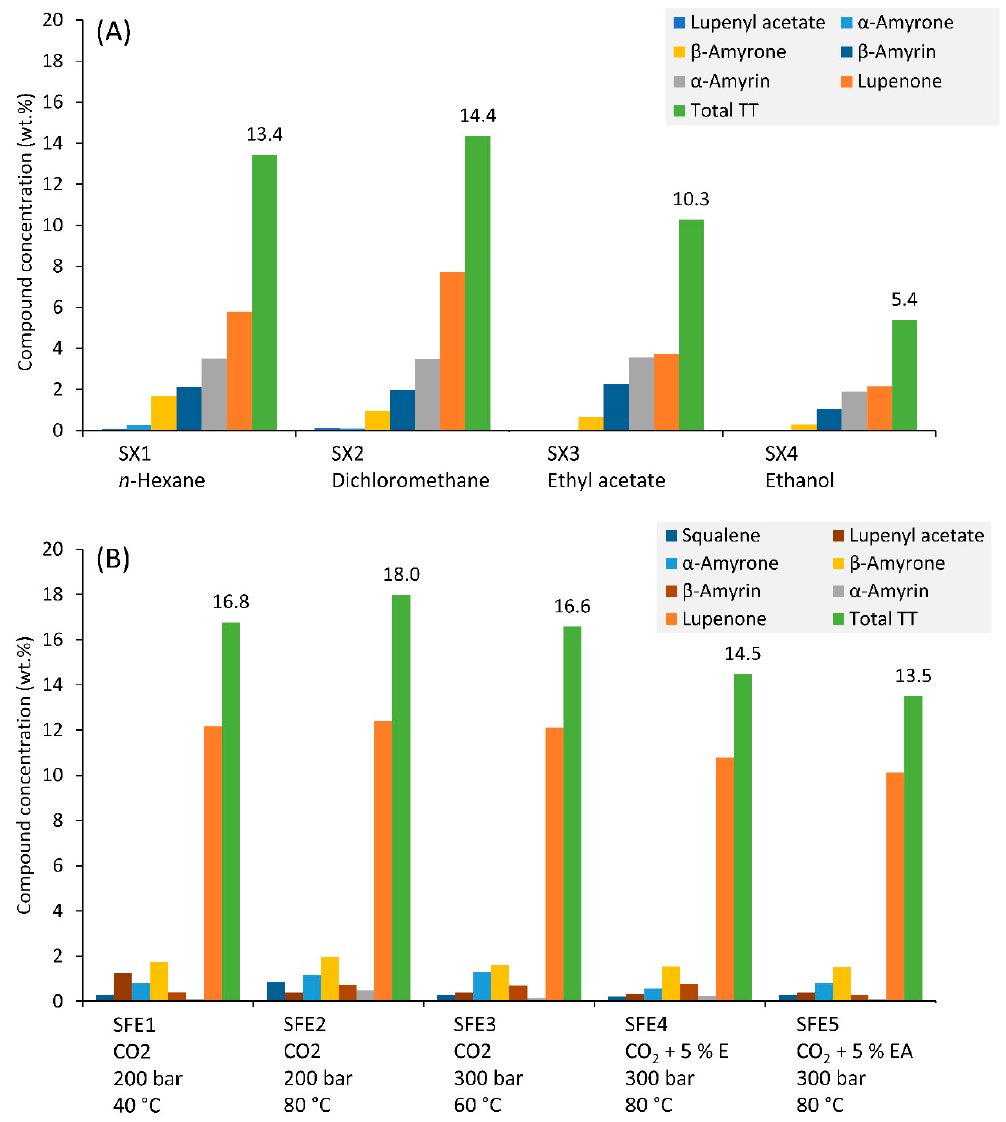
Figure 8. Plots of the concentrations of individual triterpenoids identified in ( A ) Soxhlet extracts and respective solvents, and ( B ) SFE at different conditions of temperature, pressure, and addition of ethanol (E) and ethyl acetate (EA) as modifiers.